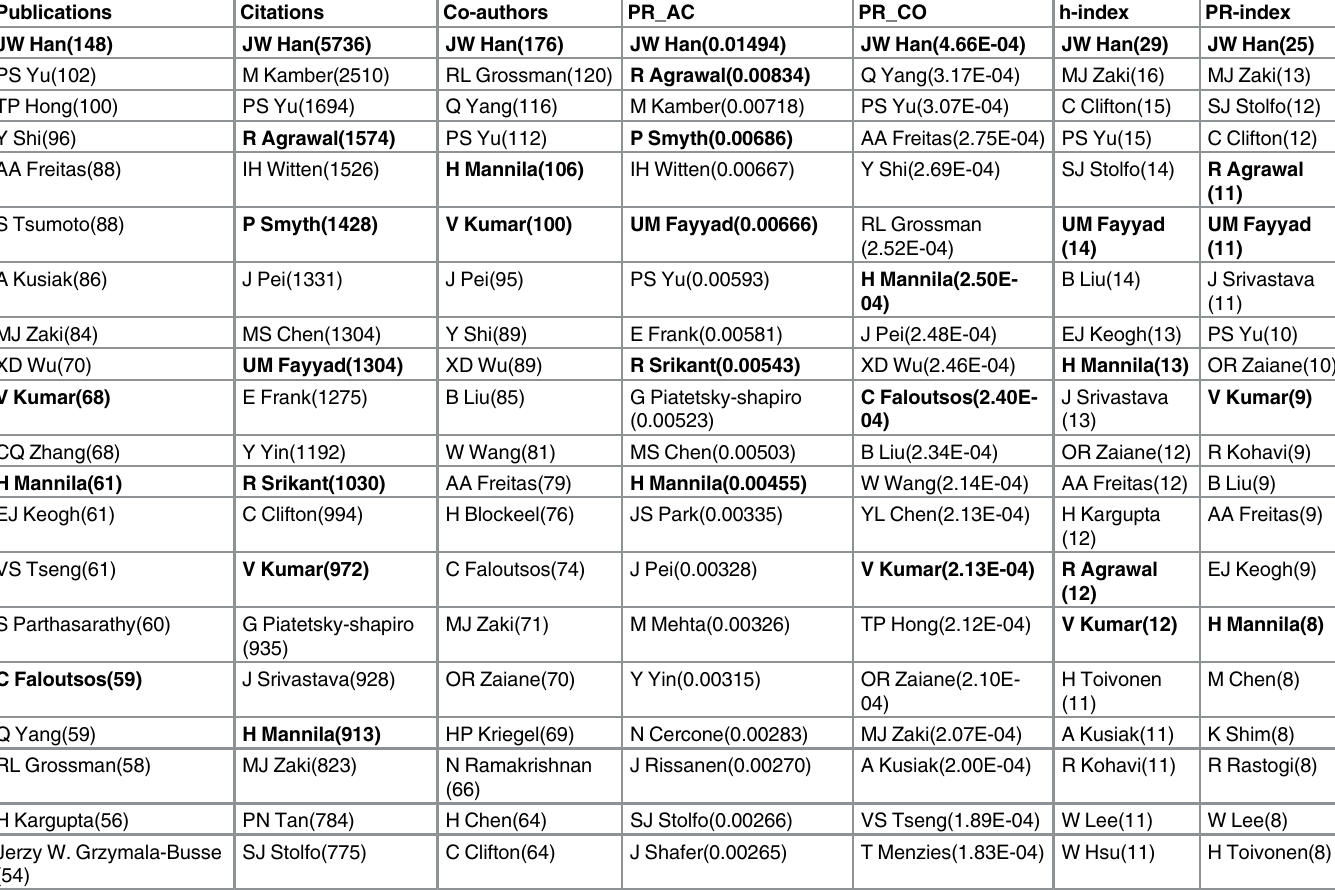
Table 2. Each column presents the top 20 authors ranked by different indicators. Some authors who are SIGKDD by innovation award winners are highlighted with the boldface. The bracketed number indicates the scores of authors according to different